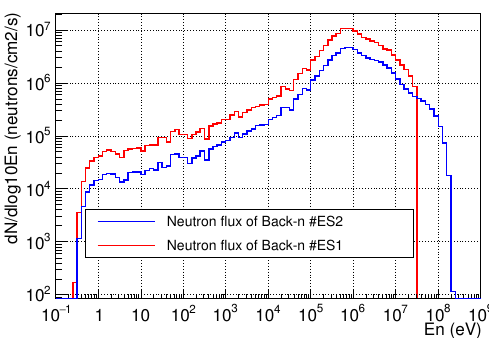
Figure 8: Comparison of the neutron energy spectrum of Back-n #ES1 and #ES2.